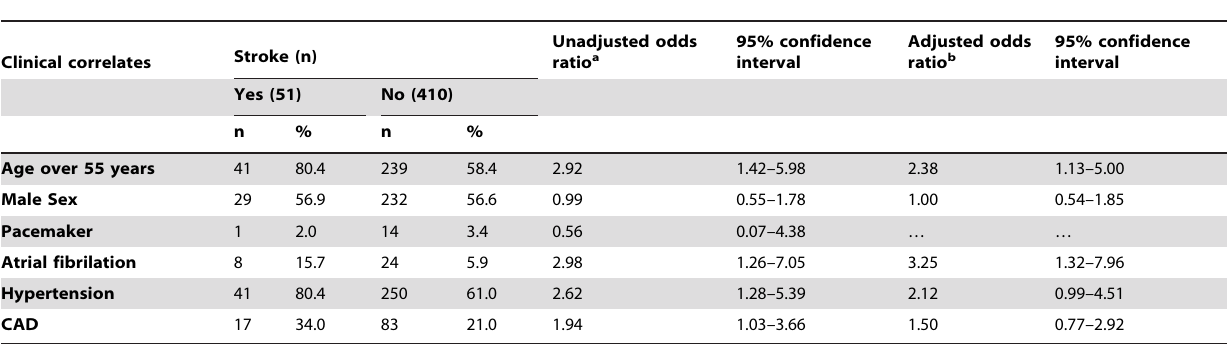
Table 3. Stroke Correlates in Non-Chagasic